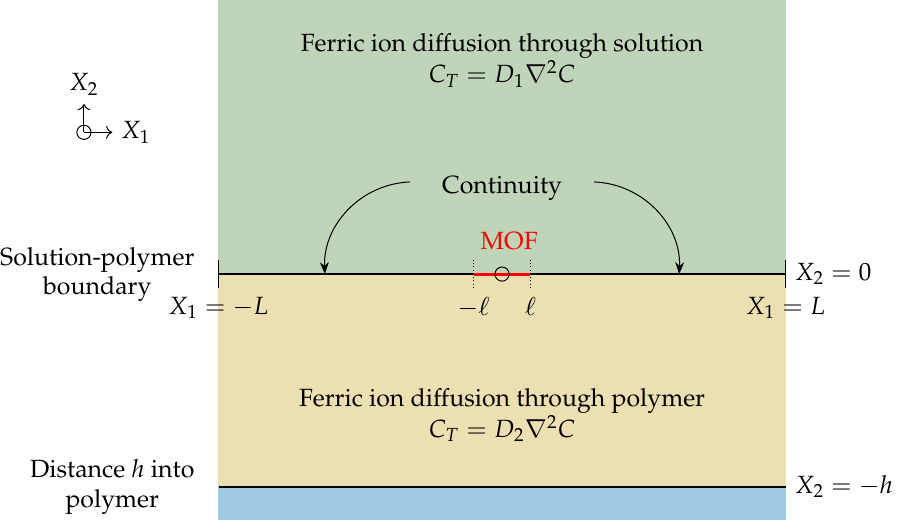
Figure 2. Two-dimensional system: X 1 -axis is solution–polymer boundary, X 2 > 0 is distance into solution, and X 2 < 0 is into polymer